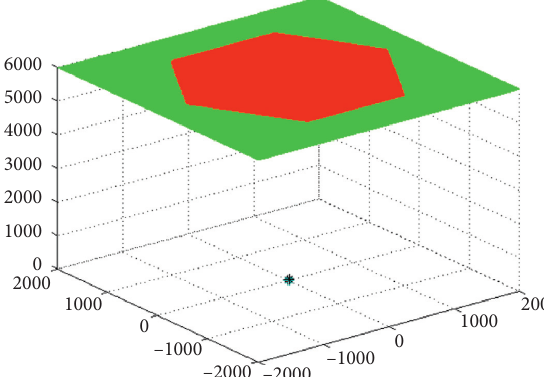
Figure 5: Measurable range on the z � 6000mm